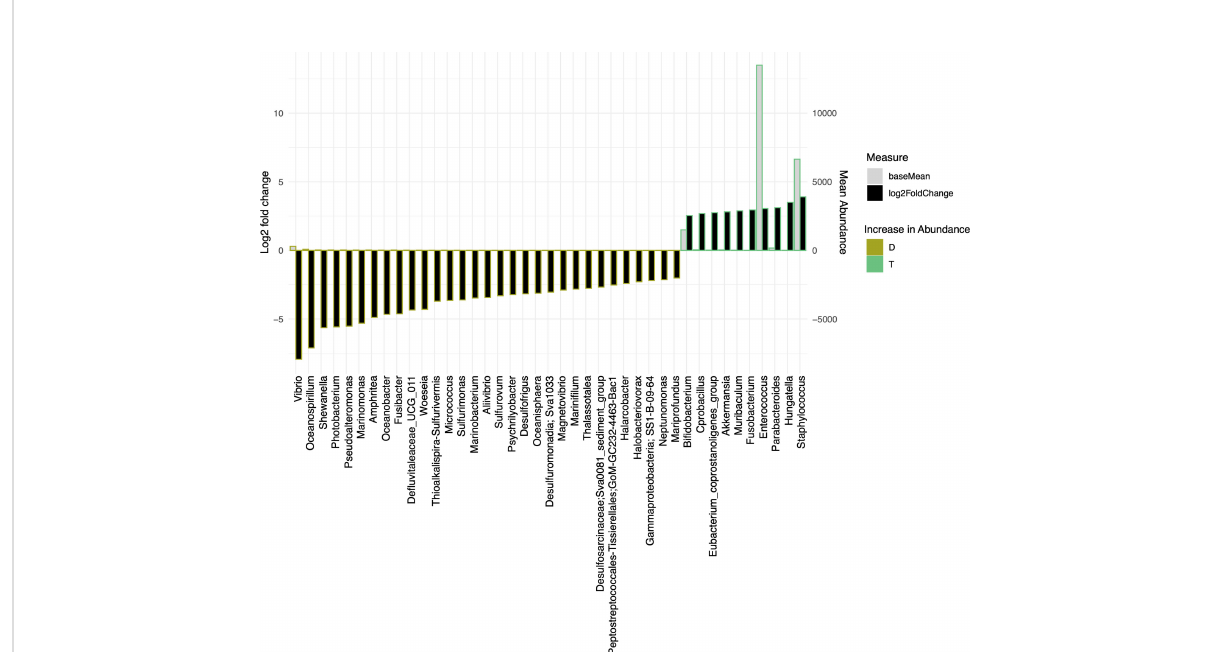
FIGURE 5 The bar charts show Log2 fold change in abundance of signi fi cant genera between groups (y-axis on the left and black bar) and the mean abundance across all the samples (y-axis on the right and light grey bar). Taxa increased in D (Droplet + YCFA) have bars with a mustard border